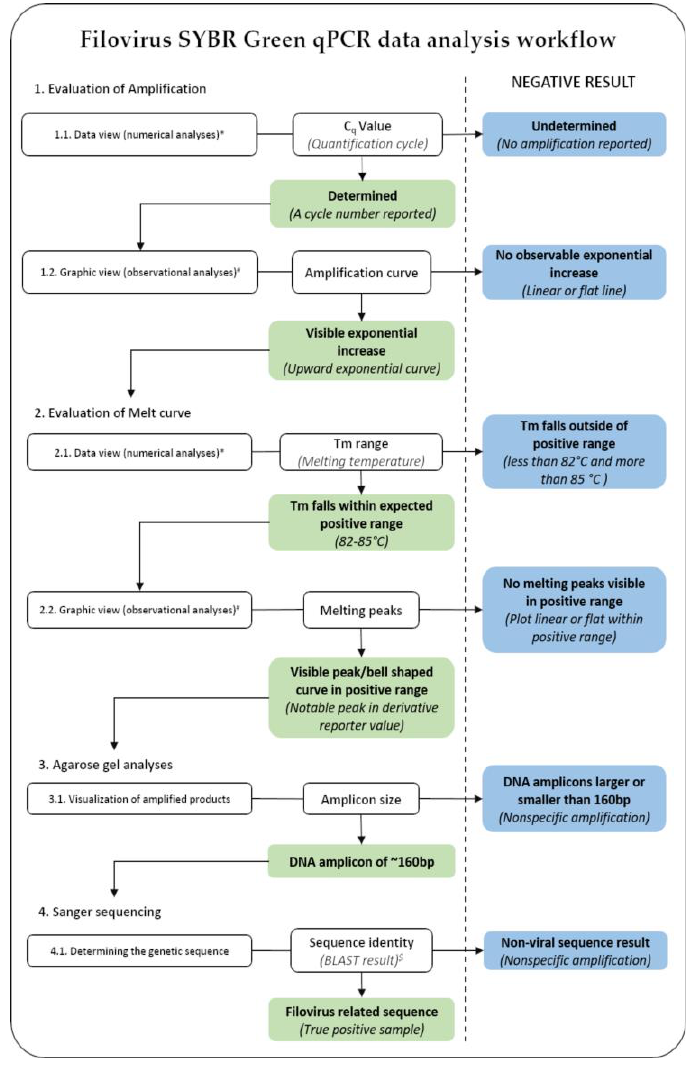
Figure 2. Filovirus SYBR Green qPCR data analysis workflow. The diagram depicts the workflow to assess individual samples at several steps to determine the additional analyses required for suspected positive samples. Results indicated in light blue represent negative samples and no further analyses were needed. Findings indicated in light green require further data analyses indicated with arrows. *: Numerical values of the C q /Tm provided; #: Visual representation of the amplification/melt curve plots; $: Analyses of nucleotide sequences using the BLAST function of the National Center for Biotechnology Information (NCBI) database (accessible online at https: //blast.ncbi.nlm.nih.gov/Blast.cgi (accessed on 10 January